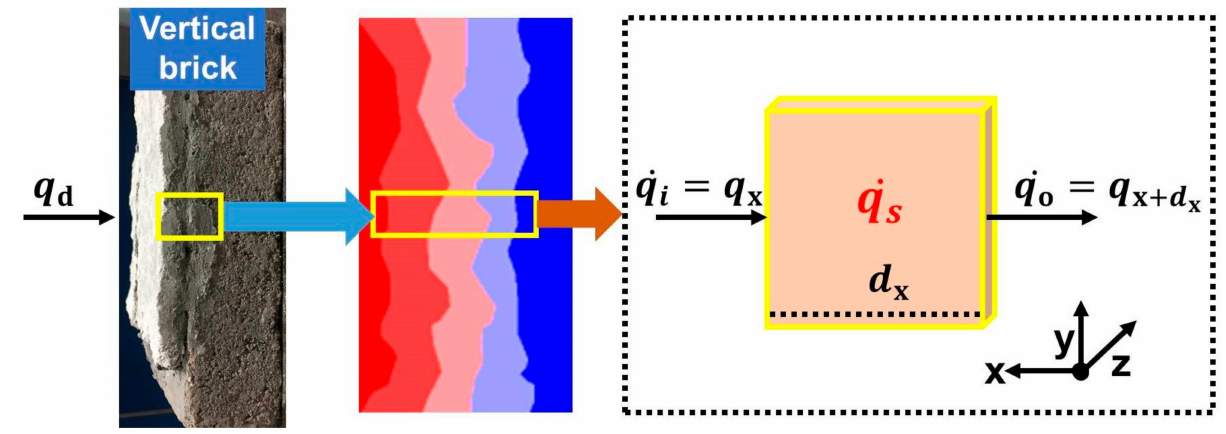
Figure 7. Heat transfer and distribution mechanism through